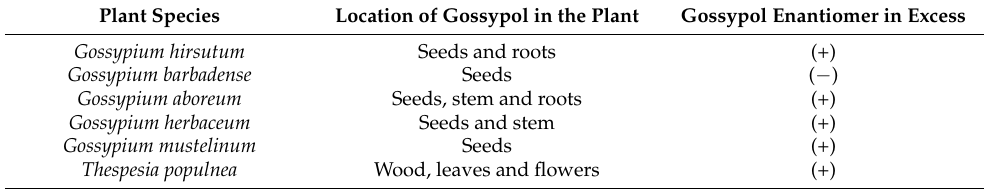
Table 1. Plant species containing gossypol [9].